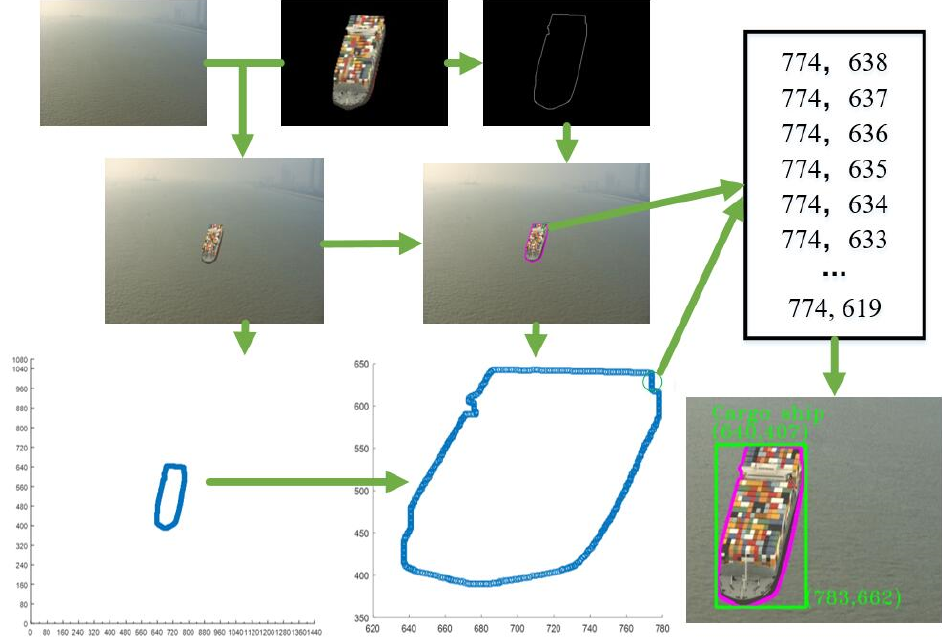
Figure 8. The automatic annotation method proposed in this paper.